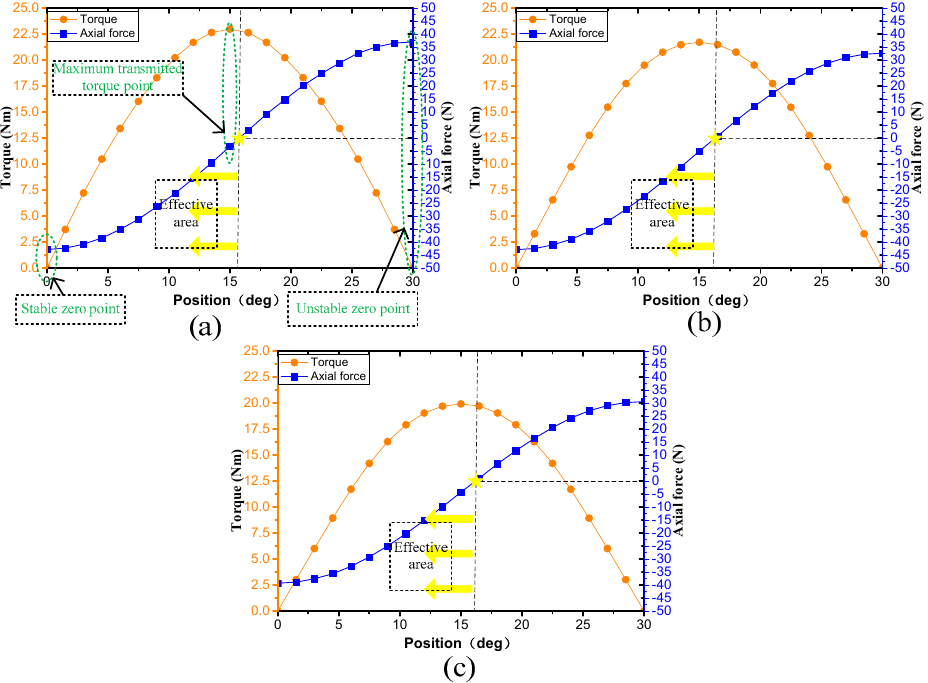
Figure 9. Axial force and transmitted torque of three types of HPMCs with 2 mm axial displacement. ( a ) Type-1, ( b ) Type- 2, and ( c ) Type-3.